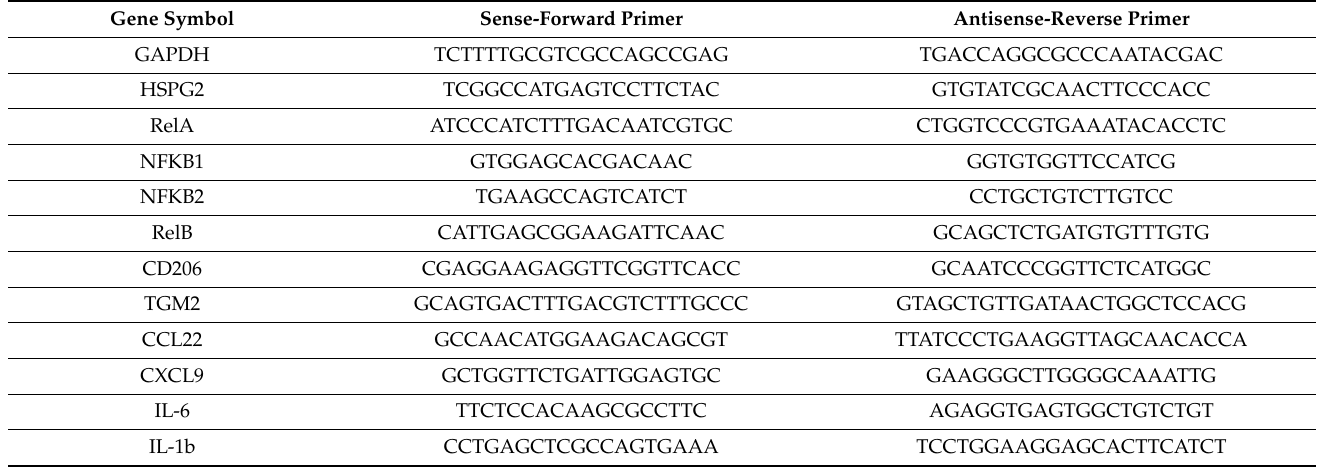
Table 1. Human primer sequences for qRT-PCR